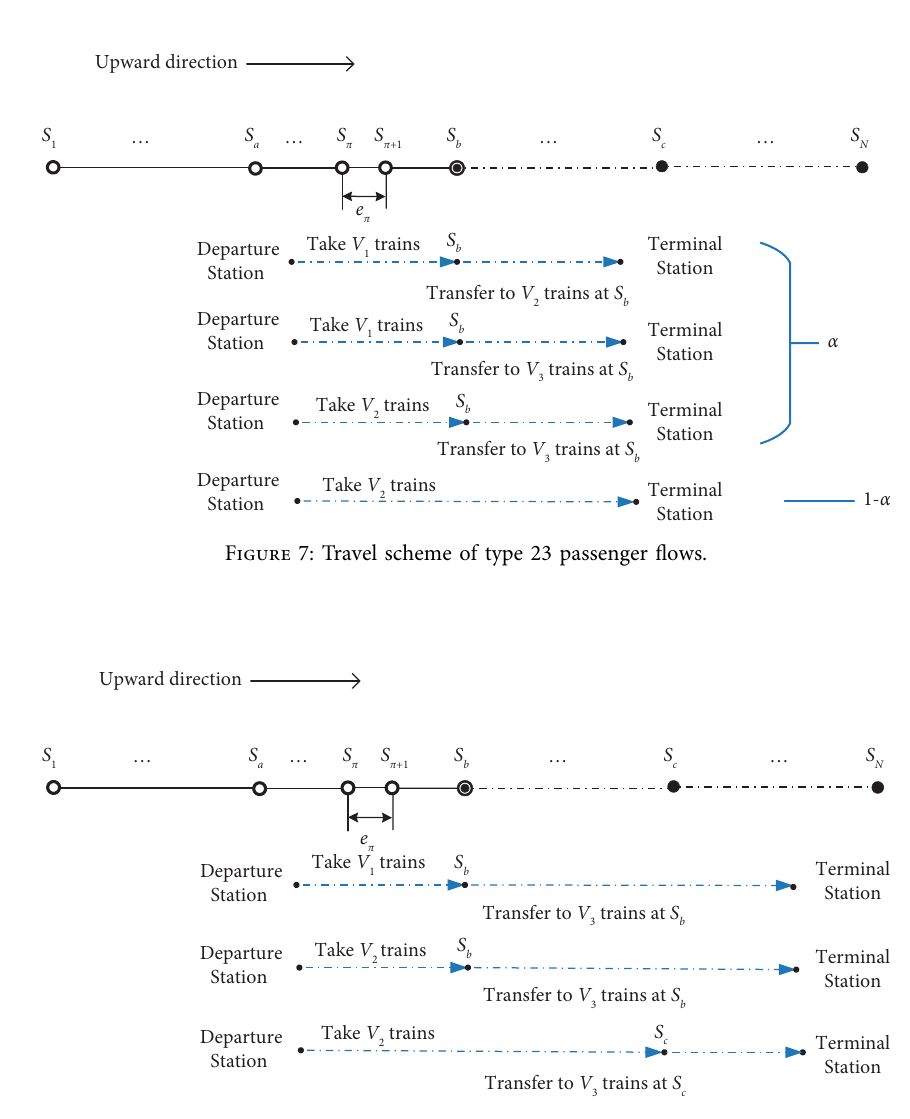
Figure 8: Travel scheme of type 24 passenger